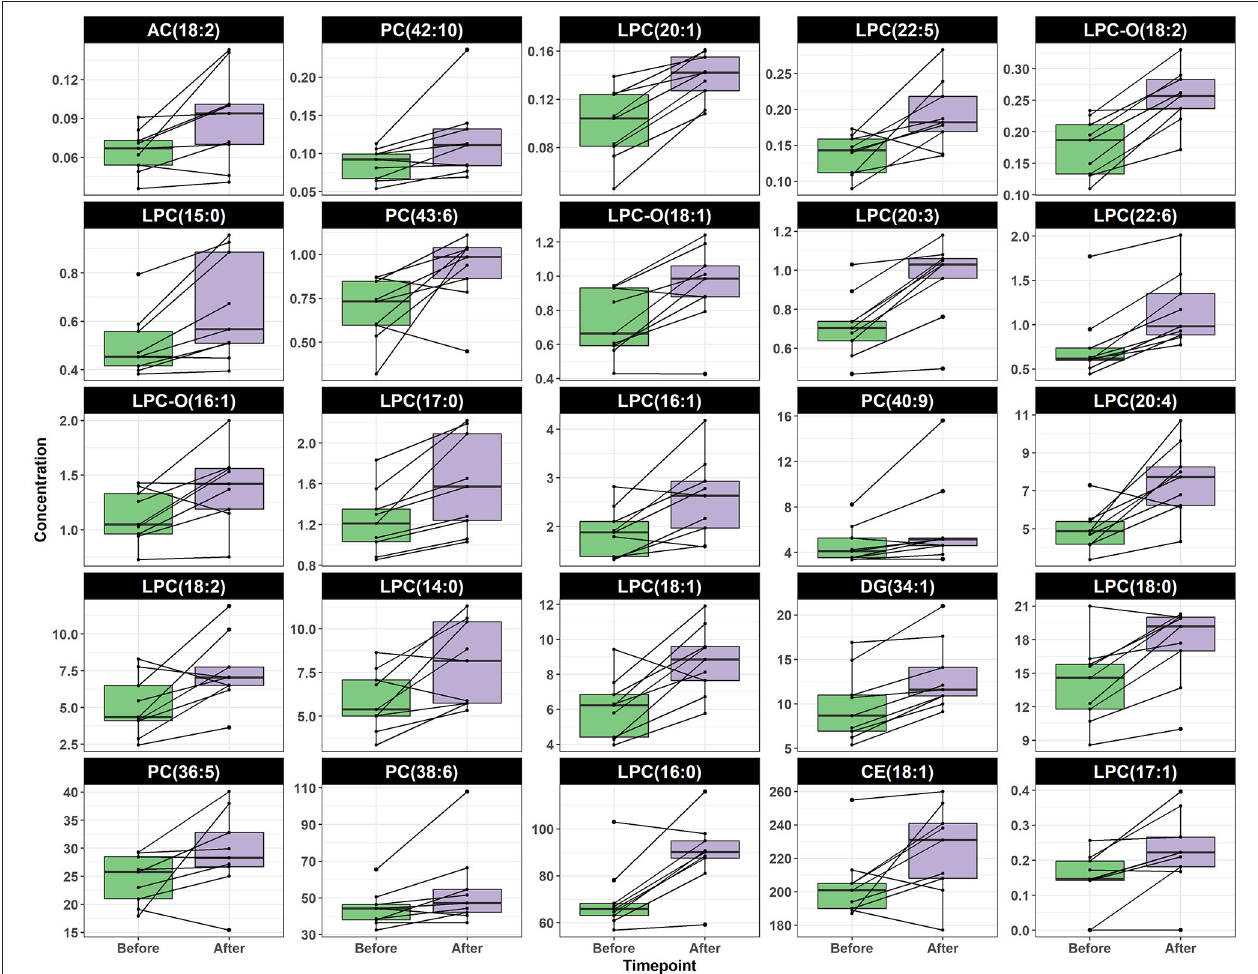
FIGURE 4 | Boxplot shows the concentration of lipids metabolites before and after TC intervention. Paired samples are linked by a line for each subject. All shown metabolites were significantly increased after intervention ( p < 0.05).